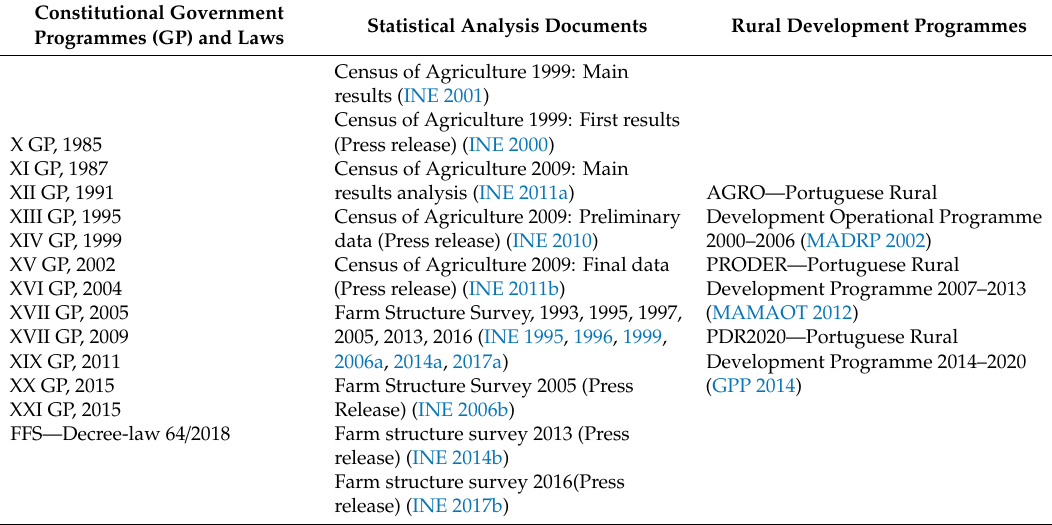
Table 2. Sources of